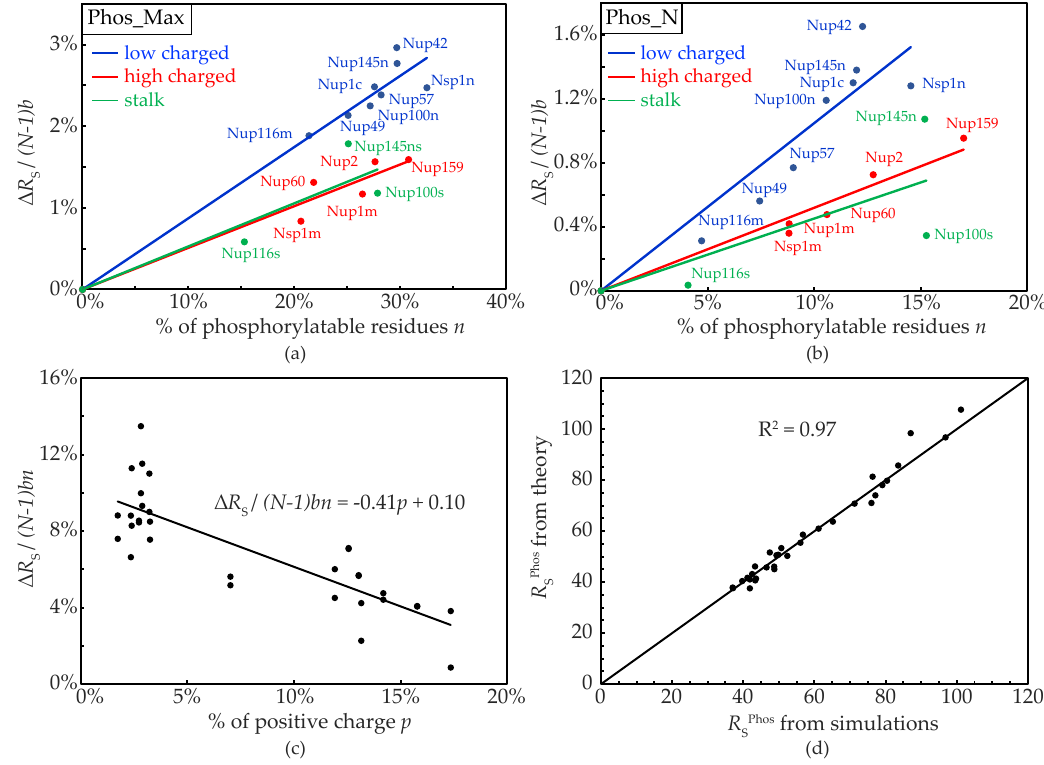
Figure 2. The normalized change in R (i.e., ∆ R / ( N − 1 ) b ) due to phosphorylation as a function of S S the fraction of phosphorylatable residues ( n ) for ( a ) the Phos_Max and ( b ) the Phos_N scenarios [37]. = R phos − R native The expression for the change in R (i.e., ∆ R ), with R phos and R native being the Stokes S S S S S S radii of the FG-Nup segments in the phosphorylated and native states, respectively, is normalized with ( N − 1) b where N is the total number of residues of the FG-Nup segment, and b (= 3.8 Angstrom) is the coarse-grained bond length between neighboring amino acids [35,46]. The data for the FG-Nups from the high charged ( hc ), low charged ( lc ), and stalk ( s ) segments [35,39] are represented in red, blue, and green data points, respectively. The data points of each group are fitted to a straight line passing through the origin revealing different slopes for different groups. For Phos_Max we observe slopes of 0.087 for lc ( R 2 = 0.94), 0.051 for hc ( R 2 = 0.92), and 0.053 for s ( R 2 = 0.80), respectively, whereas for Phos_N the slopes are 0.1 for lc ( R 2 = 0.86), 0.052 for hc ( R 2 = 0.95) and 0.045 for s ( R 2 = 0.61). ( c ) The ratio of normalized change in R to the fraction of phosphorylatable residues ( n ) is plotted as a S function of the fraction of positively charged residues ( p ) for all data points (black) from the Phos_Max and Phos_N scenarios. These data points are fitted to a linear equation, as shown in the figure (giving R 2 = 0.68). ( d ) The R phos predicted from the theory in Equation (1) compared to R phos computed from S S the MD simulations, both in Angstrom, show a good agreement with a fitness measure of R 2 =